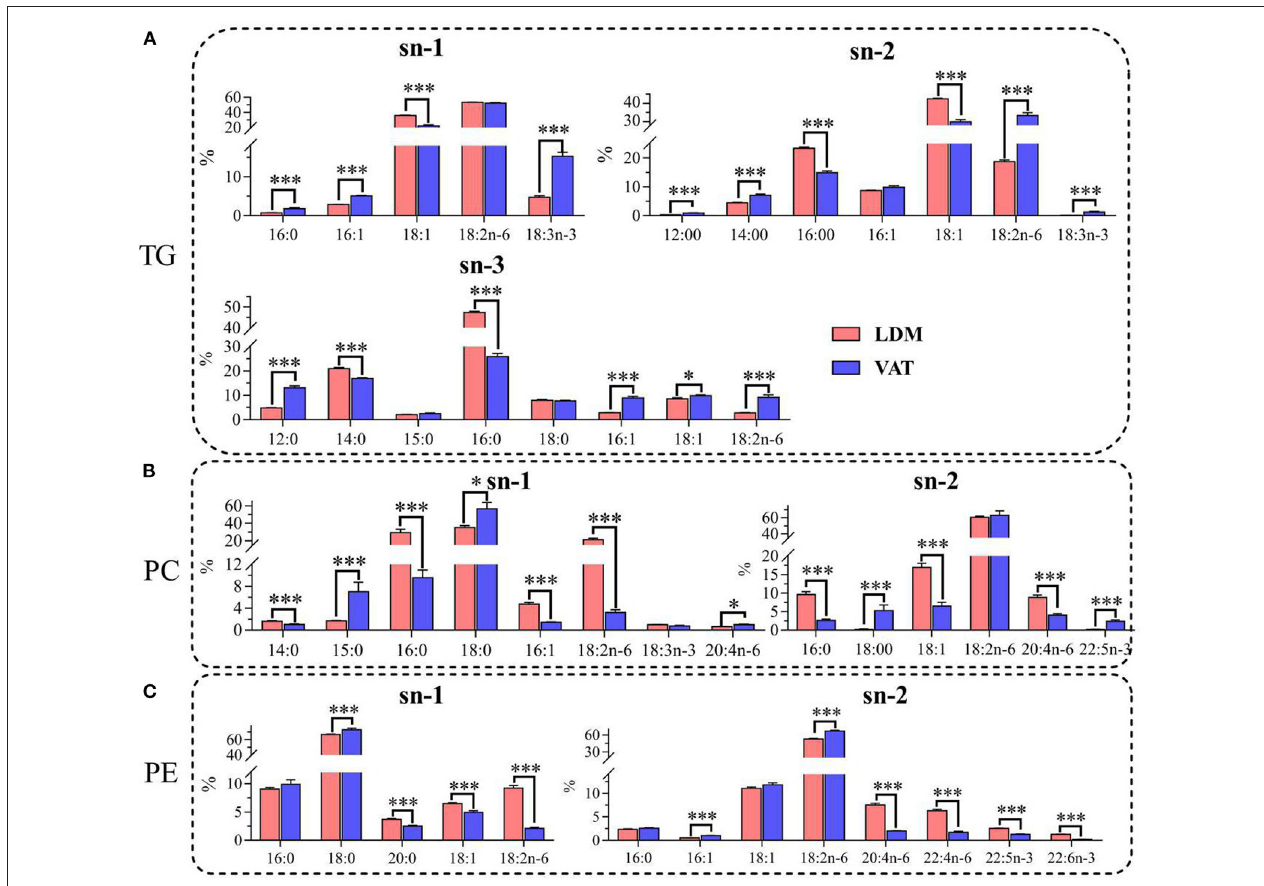
FIGURE 2 | Positional distributions (sn-1, sn-2, and sn-3) of fatty acids in (A) TGs, (B) PC, and (C) PE in LDM and VAT of Dezhou donkey. Values are presented as means ± SEM ( n = 9), * p < 0.05, *** p < 0.001. TG, triglyceride; PC, phosphatidylcholine; PE, phosphatidylethanolamine.